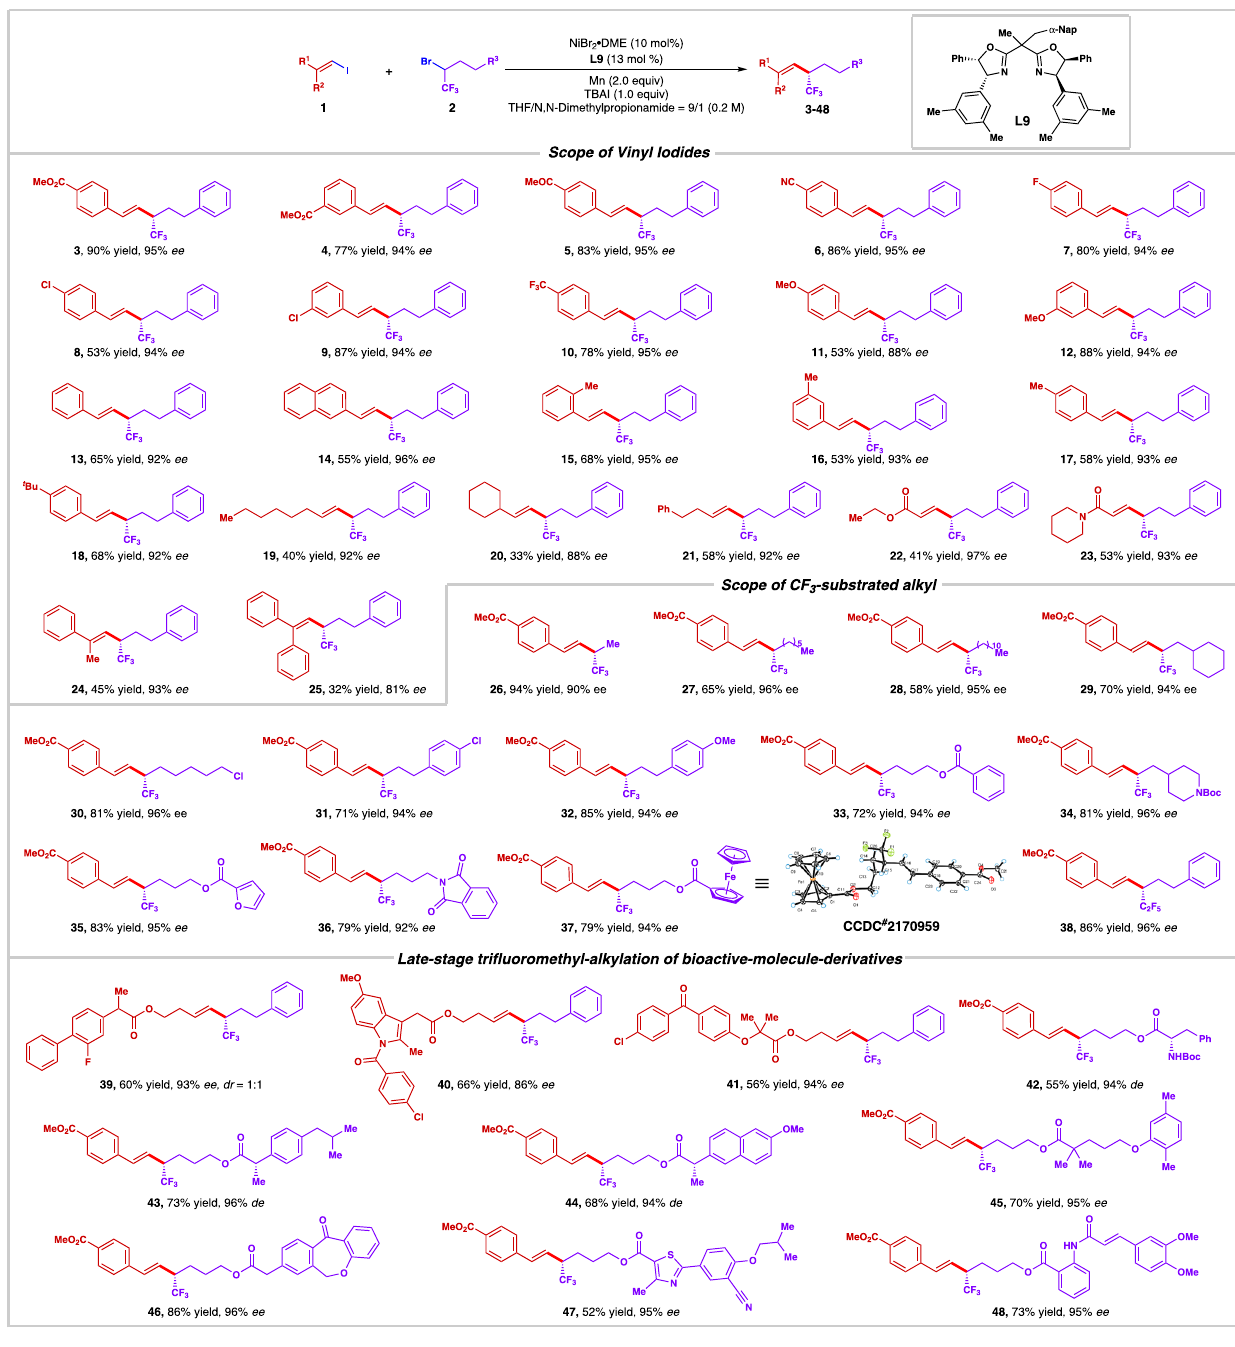
Fig. 2 | Nickel-catalyzed asymmetric reductive tri fl uoroalkylation of vinyl iodides. Reaction conditions: 1 (0.10mmol, 1.0 equiv), 2 (0.20mmol, 2.0 equiv), NiBr 2 (cid:129) DME (10mol%), L9 (13mol%), Mn (0.20mmol, 2.0 equiv), TBAI (0.10mmol,